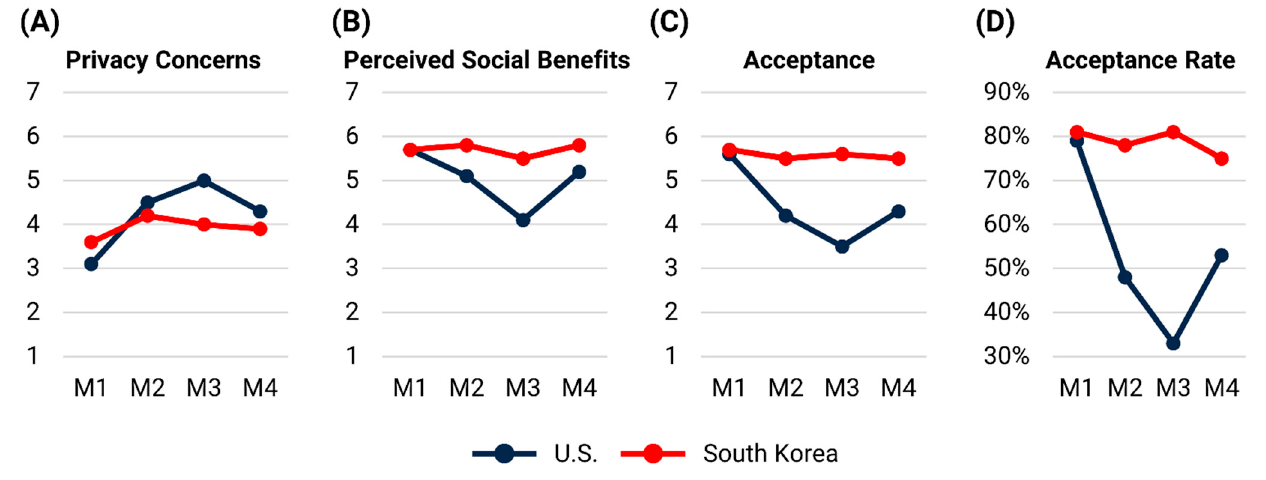
Figure 3. ( A ) Average privacy concerns; ( B ) Average perceived social benefits; ( C ) Average acceptance; ( D ) Acceptance rate (M1–4).